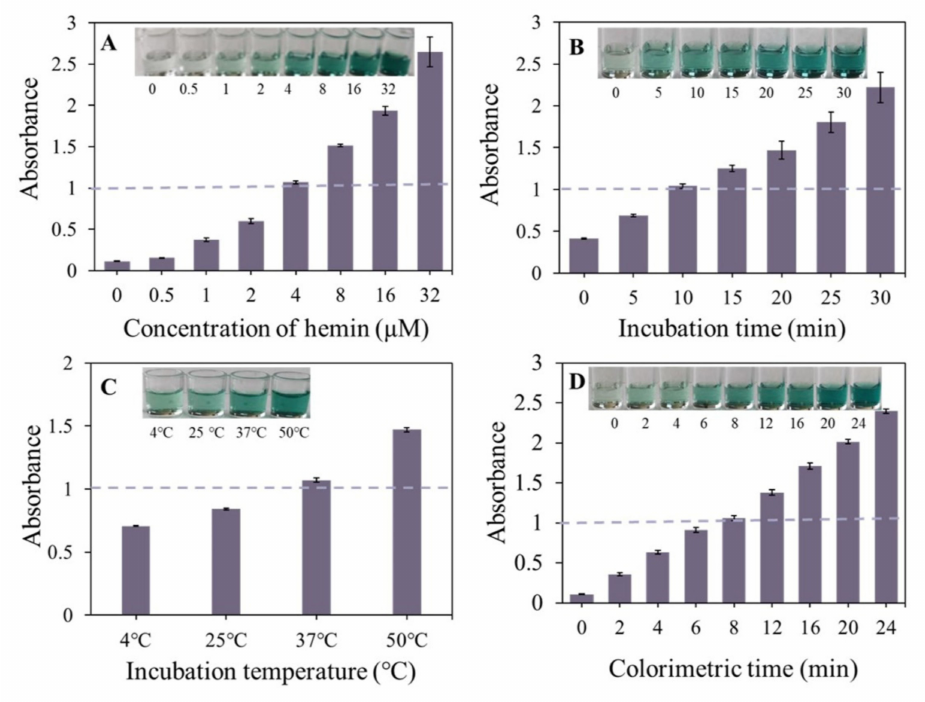
Figure 3. Optimization of the G-4/hemin colorimetric conditions. ( A ) Concentration of hemin. ( B ) Incubation time of between G-4 and hemin. ( C ) Working temperature. ( D ) Reaction time between G-4/hemin and